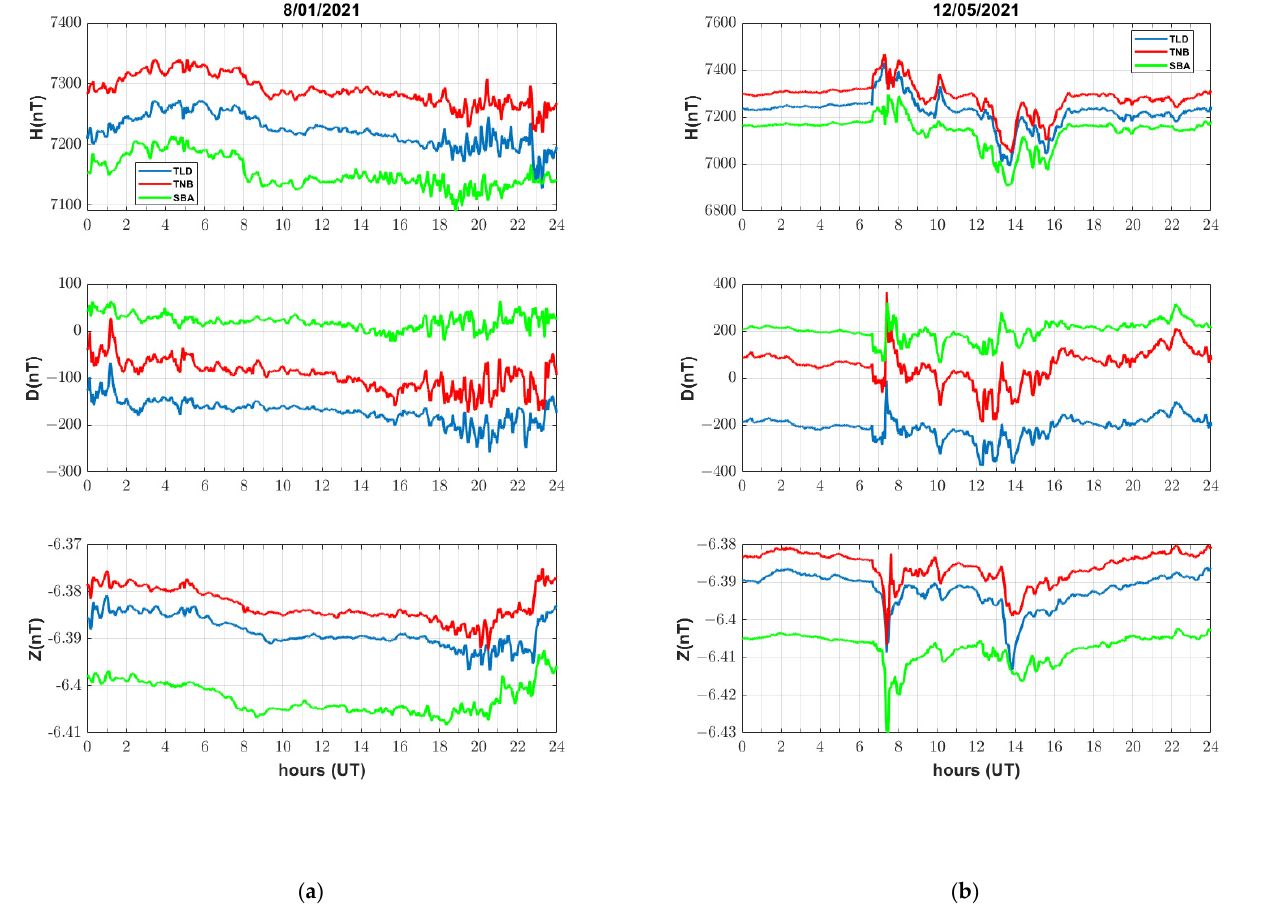
Figure 5. Example of the daily magnetograms of the components H, D, Z at TLD (blue line), TNB (red line) and SBA (green line) for a quiet day ( a ) and for a disturbed day ( b ). In both Figures, an arbitrary value has been added to each time series to show the variations in the same plot.